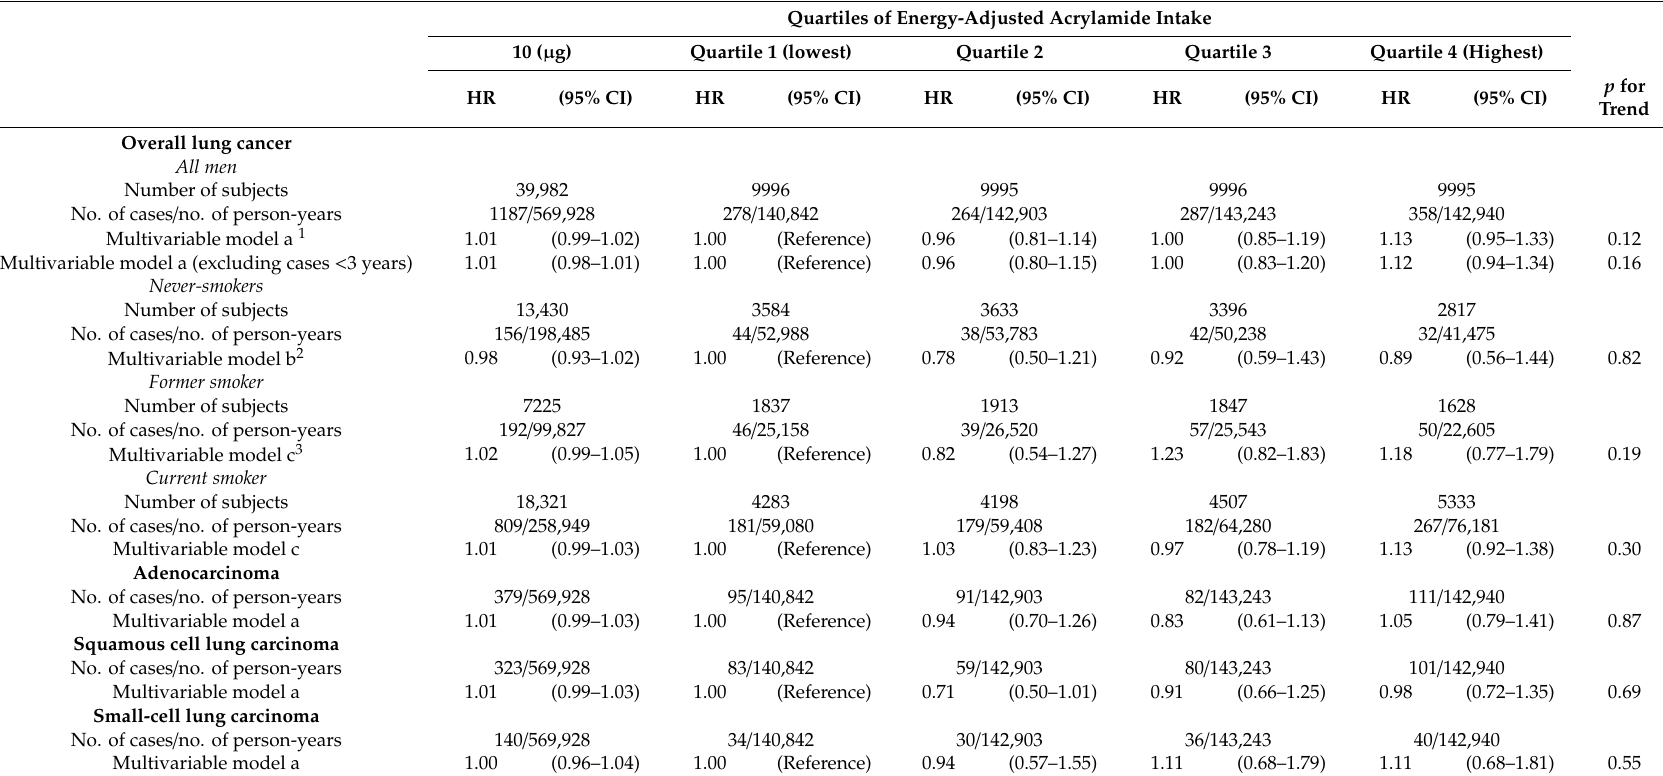
Table 2. Hazard ratios (95% confidence intervals) for lung cancer in men according to quartiles of acrylamide